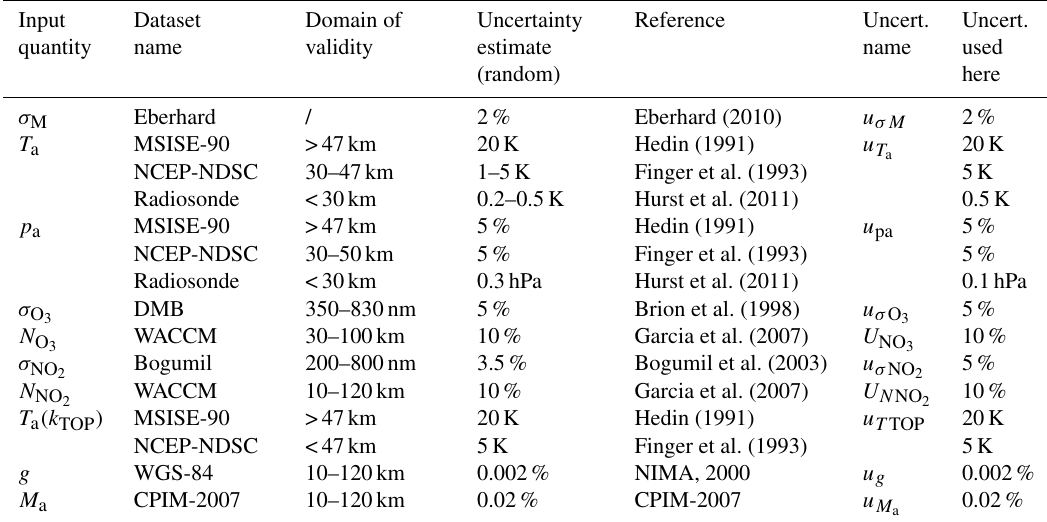
Table 2. Input quantities and their uncertainty used to compute the temperature uncertainty budget presented in Fig. 10. Input Dataset Domain of Uncertainty Reference Uncert. Uncert. quantity name validity estimate name used (random)